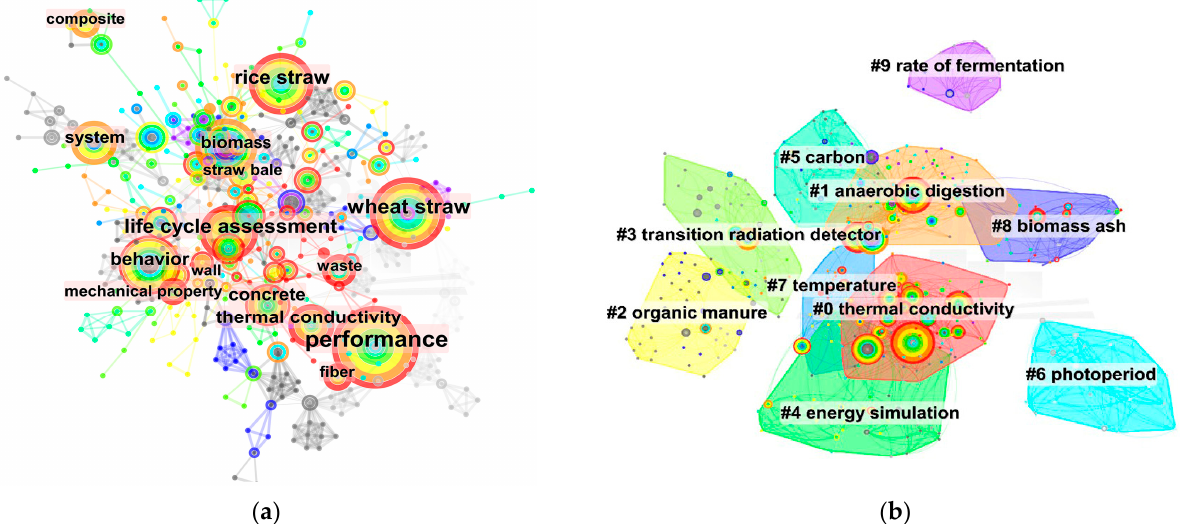
Figure 6. ( a ) Keyword co-occurrence network; ( b ) keyword clustering analysis pro fi le.